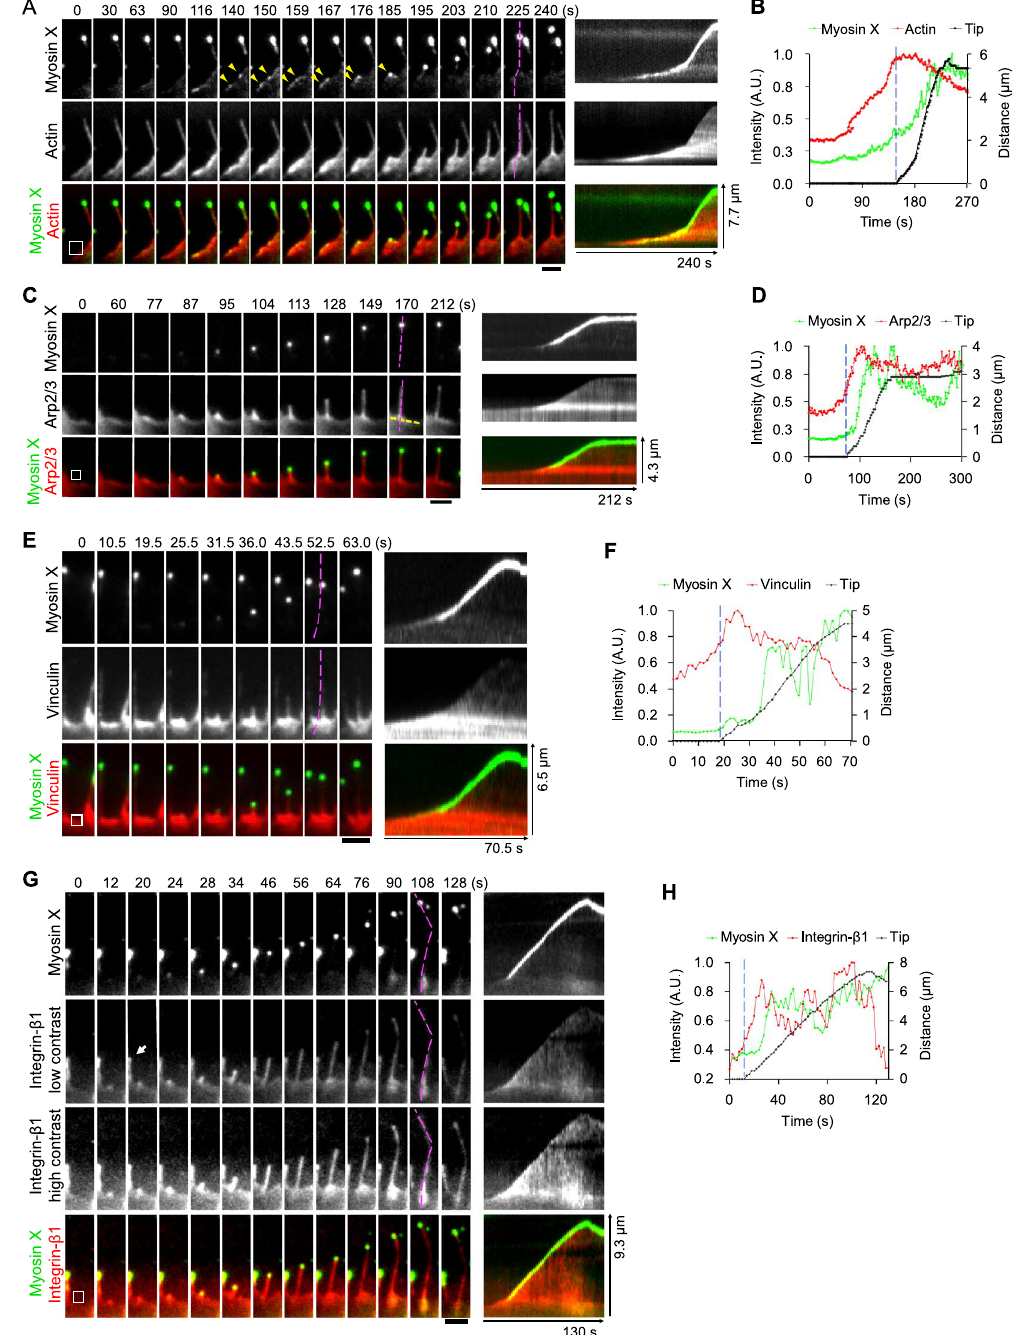
Figure 2. Spatiotemporal dynamics of myosin X, actin and actin-regulating proteins during myosin X-induced filopodia formation. Time-lapse montages showed the dynamics of EGFP-myosin X and mCherry-actin ( A ), EGFP-myosin X and mCherry-Arp2/3 ( C ), EGFP-myosin X and vinculin-tomato ( E ), EGFP-myosin X and integrin- β 1-mCherry ( G ) during filopodia formation imaged using dual-color TIRFM. The corresponding kymographs of these proteins along filopodial extension (purple dashed lines) are shown. The yellow arrows in ( A ) show the lateral movement and then fusion of two EGFP-myosin X puncta during filopodia formation. ( B , D , F and H ) The fluorescence intensity of EGFP-myosin X at the base of newly formed filopodia (mean fluorescence of the region-of-interest (ROI) boxes in A , C , E and G ; before the blue dashed lines) and at the filopodial tip during elongation (after the blue dashed lines), together with the fluorescence intensity of mCherry- actin ( B ), mCherry-Arp2/3 ( D ), vinculin-tomato ( F ) and integrin- β 1-mCherry ( H ) at the base of filopodia (mean fluorescence of the same ROI boxes in A , C , E and G ) during filopodia formation are shown. ROI boxes are shown in the first images of each time lapse series ( A , C , E , and G ). The ROI boxes at the filopodia initiation sites are used for direct comparison between the accumulation rates of myosin X and other proteins during filopodia initiation. The time course of the change in fluorescent intensity of proteins at the site of filopodia initiation